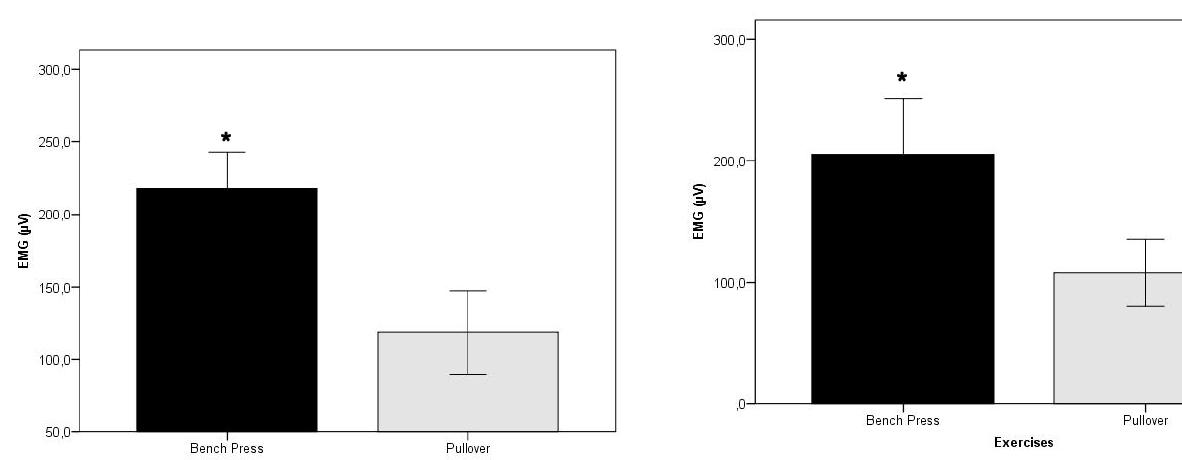
Figure 2. Comparison of the electromyographic activation of major pectoral sternal portion between horizontal bench press and barbell pullover exercises (mean and SD). # p < 0.05 - significant difference # p < 0.05 - significant difference between BP and